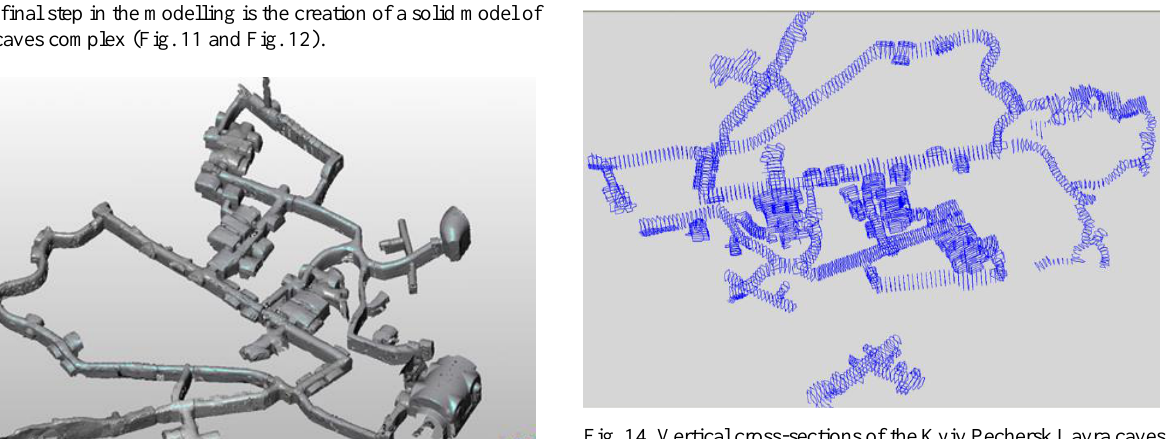
Fig. 14. Vertical cross-sections of the Kyiv Pechersk Lavra